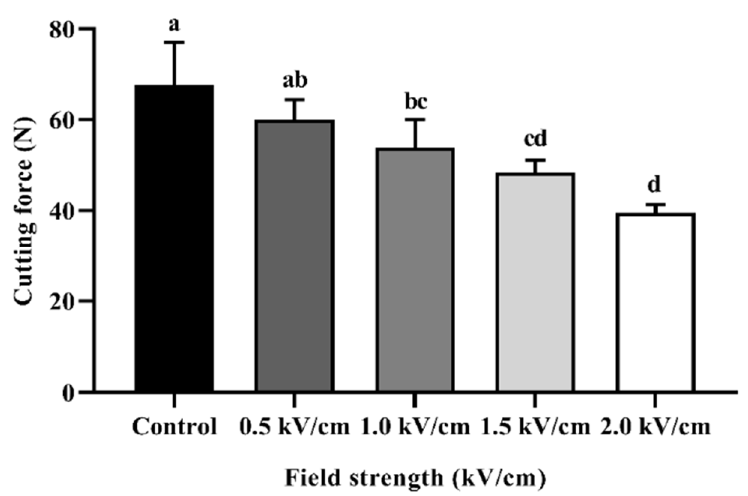
Figure 3. Cutting force for beef processed with PEF at different field strengths. Error bars indicate the standard deviation of six replications ( n = 6). Different letters indicate significant differences between means ( p < 0.05).